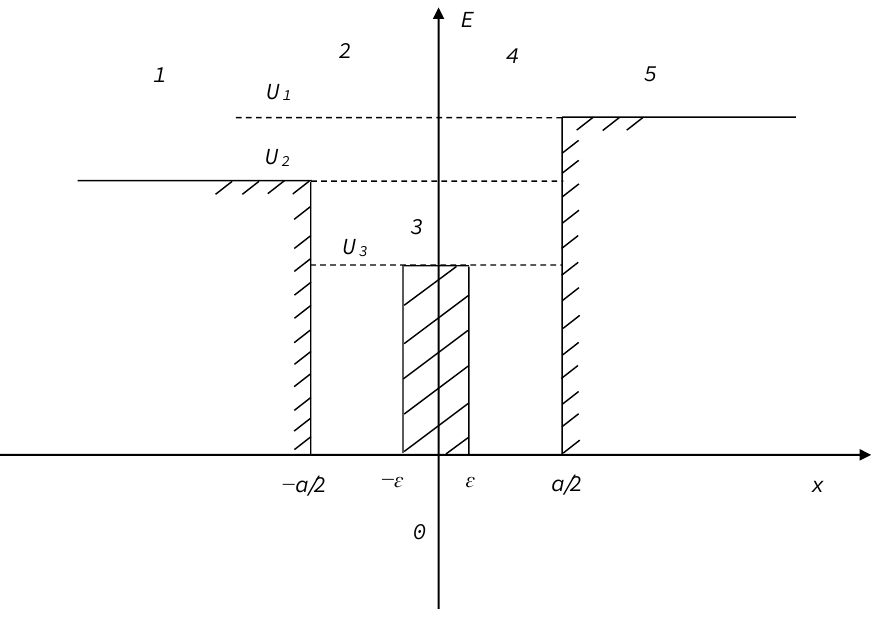
Figure 4. One-dimensional potential pit with finite walls. Variant with different walls and internal potential barrier.